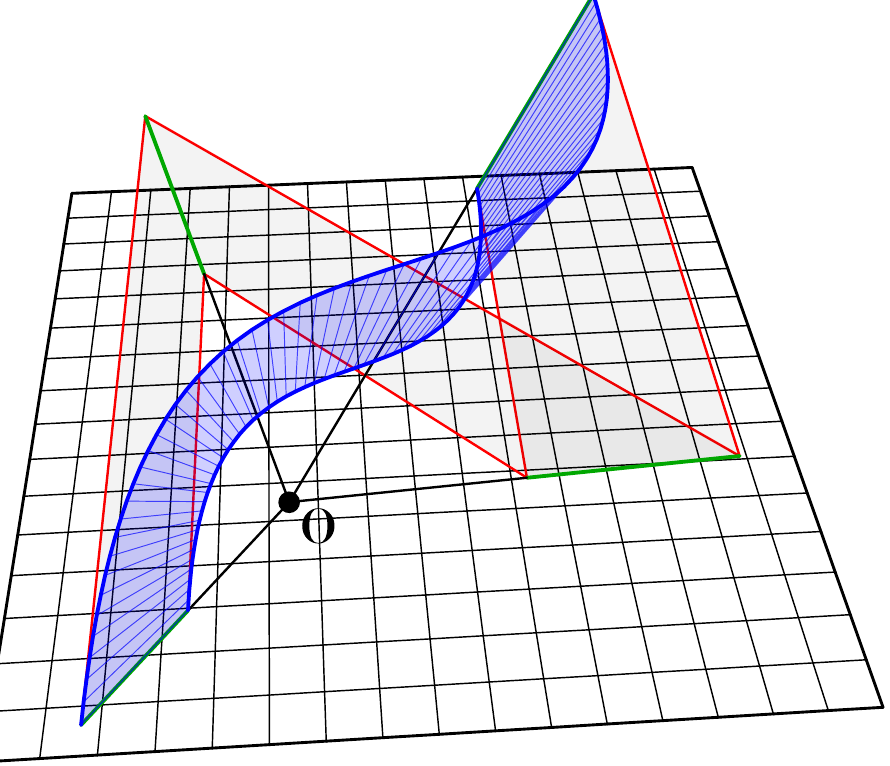
Figure 7. Developable ruled surface between two homothetic spline